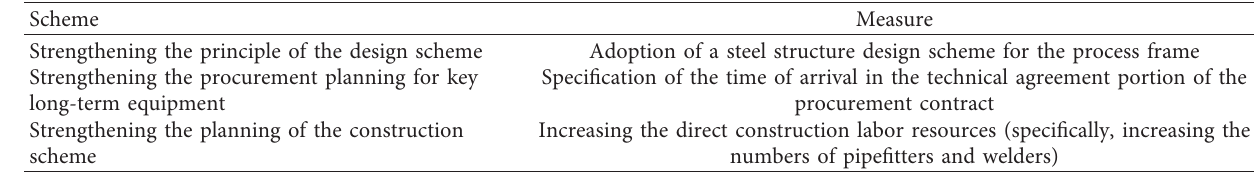
Table 9: Proposed scheduling control schemes and